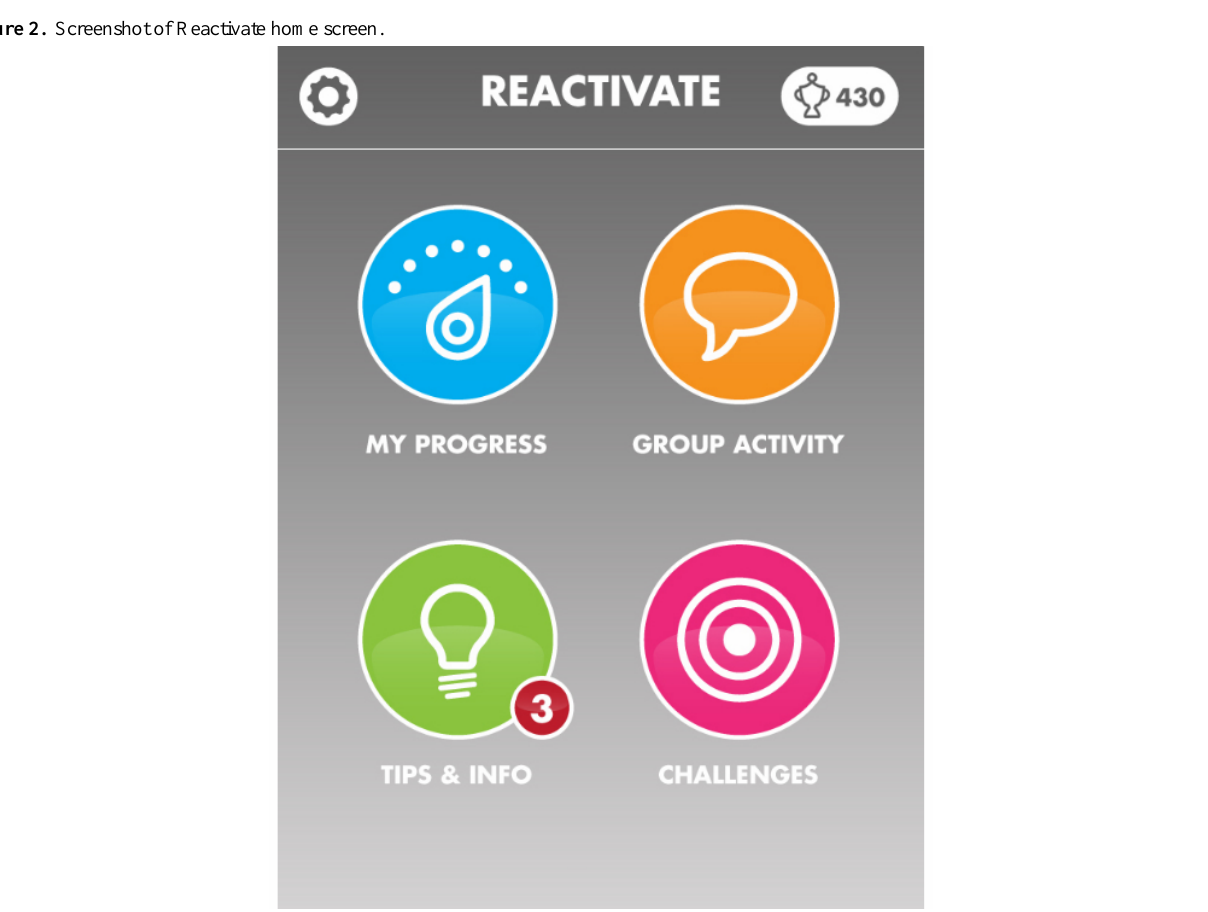
Figure 2. Screenshot of Reactivate home